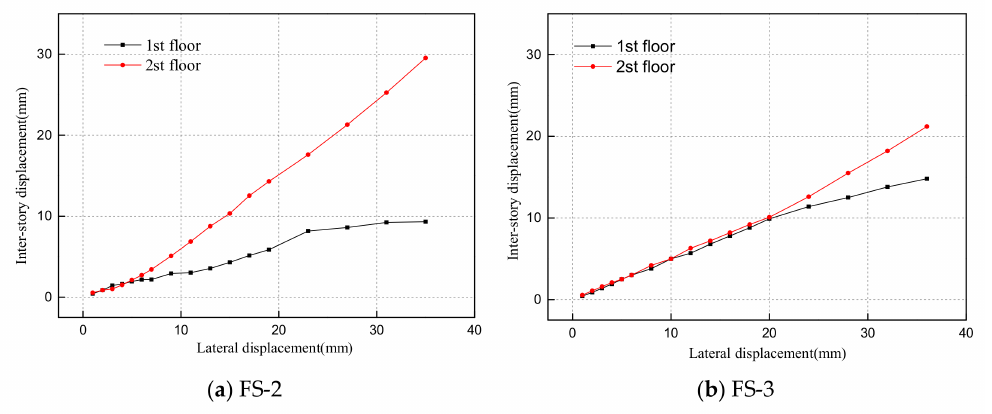
Figure 16. Inter-story displacement of